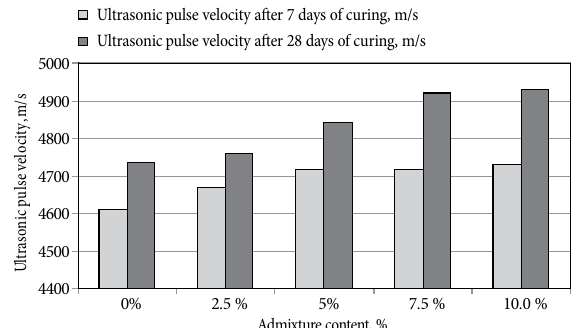
Fig. 3. Function of ultrasonic pulse velocity and amorphous alumina silicate admixture content